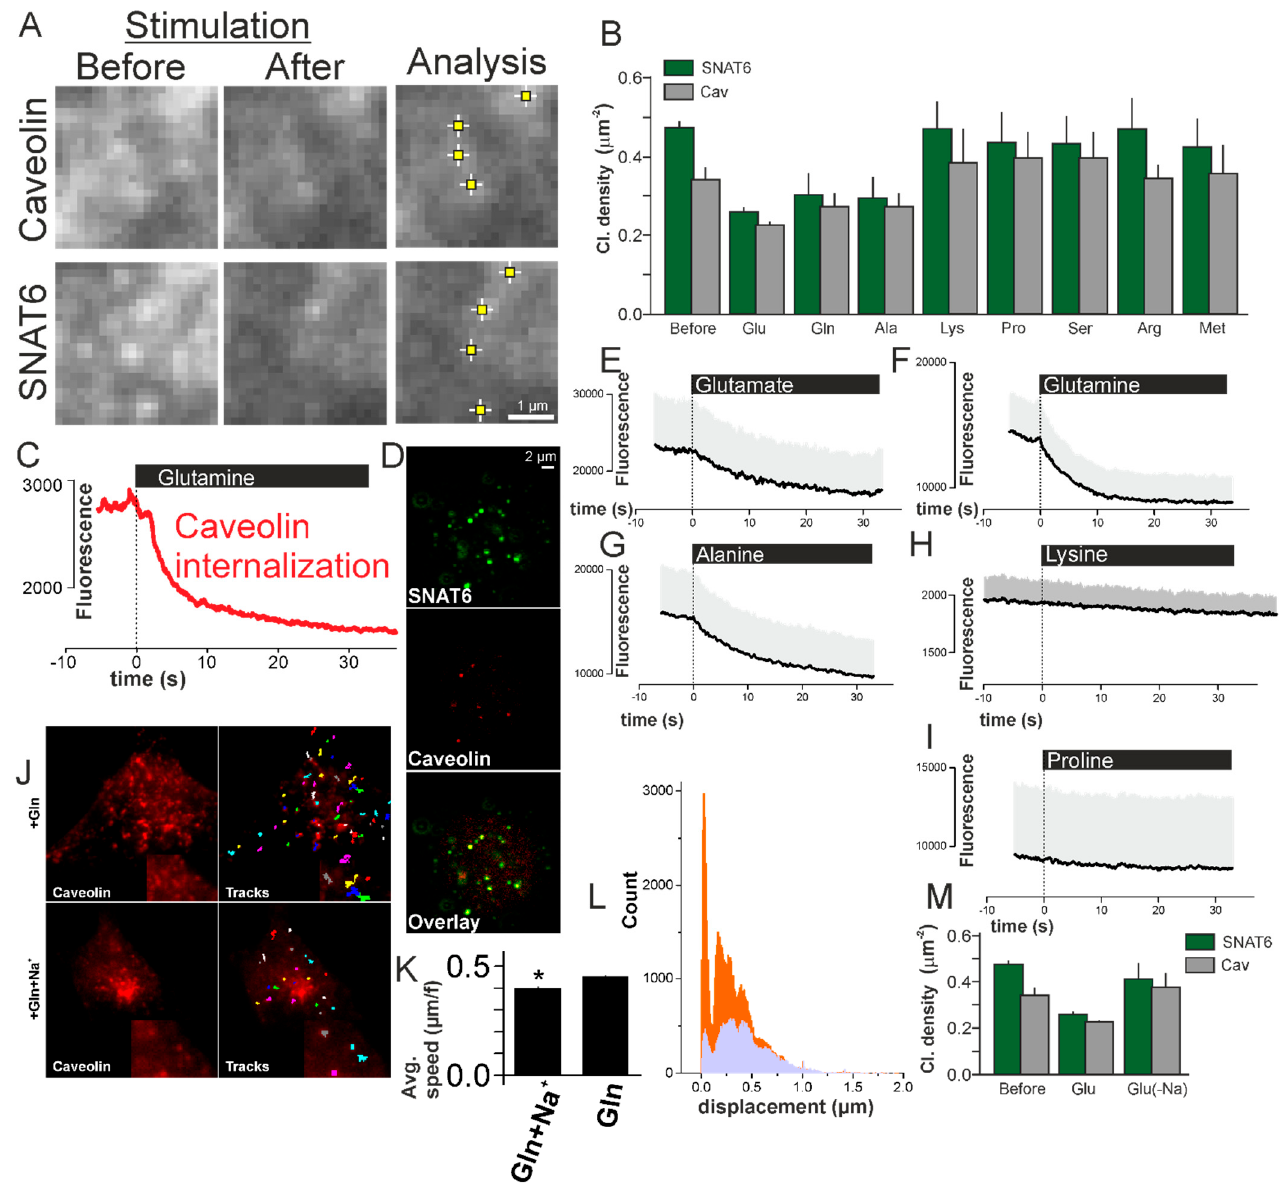
Figure 5. SNAT6 associated caveolin complexes internalize in response to glutamine and glutamate in a Na + dependent manner. ( A ) Images of cells expressing SNAT6-EGFP and Caveolin1-mCherry under TIRF microscopy before and after stimulation with glutamine. An ImageJ plugin (described in methods) detecting the SNAT6 and caveolin clusters. ( B ) Density of SNAT6 (green) and Caveolin (grey) clusters quantified using the method above before and after stimulations with different amino acids specified in the figure (density of clusters was significantly decreased under Glu, Gln, and Ala, p < 0.001). ( C ) Trace showing fluorescence of the entire single cell for caveolin. Note that the stimulation with glutamine was initiated at time zero. ( D ) Images from antibody labeled SNAT6 and caveolin localizing together (44 ± 7% in six cells derived from two independent experiments). ( E ) Similar to C but showing average fluorescence for 10 cells from three different transfections under glutamate stimulation. ( F – I ) Similar to E for cells stimulated with glutamine (11 cells), alanine (13 cells), lysine (12 cells), and proline (9 cells). All the experiments were performed from at least three different transfec- tions. ( J ) Images showing caveolin-mCherry expressing cells with and without Na + present in the buffer when stimulated with glutamine. Tracks obtained from Metamorph tracking (described in methods) during the entire time sequence. zoomed tracks and images in the inset ( K ) Average speed for the tracks in J in presence and absence of Na + in the buffer under glutamine stimulation ( p < 0.05). ( L ) Histogram of 16–60 tracks from 9 different cells per condition similar to the cell shown in I. Displacement of caveolin in presence (lavender) and absence (orange) of Na + in the buffer under glutamine stimulation. ( M ) Density of SNAT6 (green) and Caveolin (grey) clusters quantified as in B before and after stimulations with glutamine in presence and absence of Na + in the buffer.